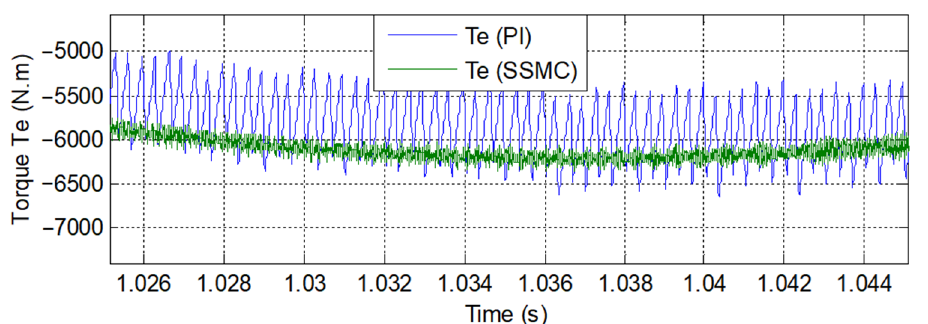
Figure 20. Zoom (Torque).